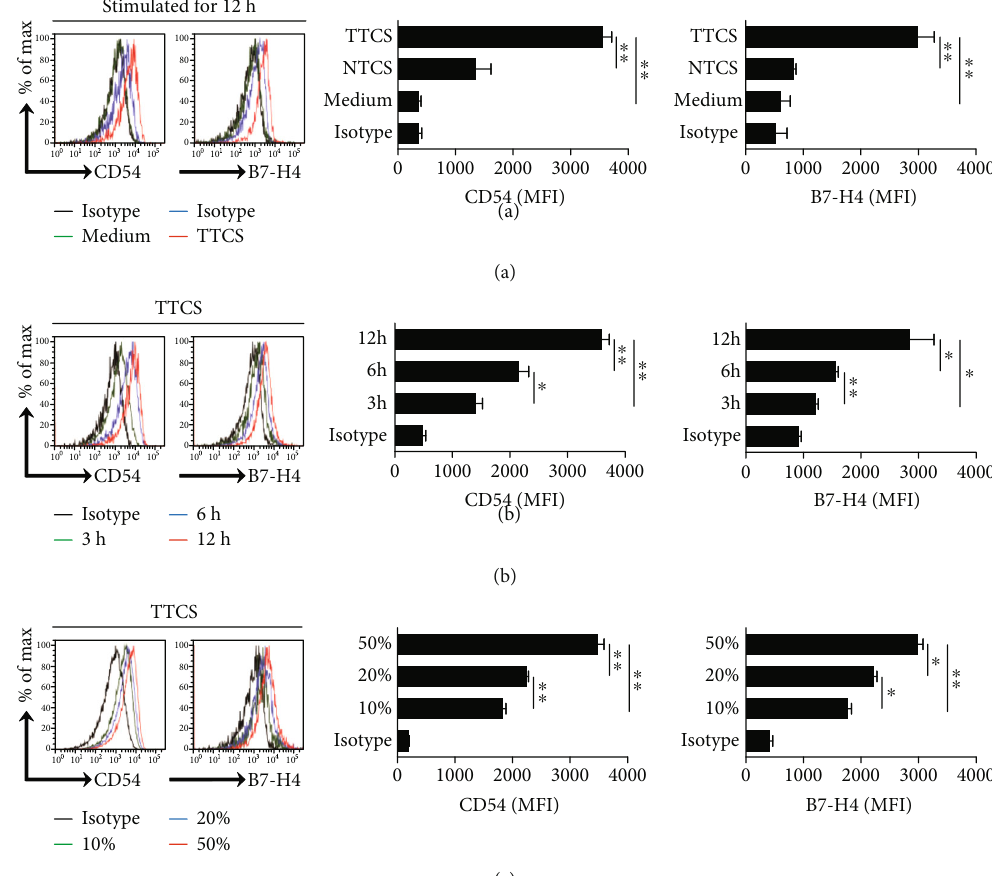
Figure 3: Human GC environments maintain neutrophil-activated and highly B7-H4-expressing phenotype. (a) Expressions of CD54 and B7-H4 on neutrophils exposed to 50% TTCS and 50% NTCS from autologous GC patients, or to medium control for 12 h. Black: isotype control. MFI: mean fl uorescence intensity. (b) Expressions of CD54 and B7-H4 on neutrophils exposed to 50% TTCS from GC patients for 3, 6, or 12 h. Black: isotype control. MFI: mean fl uorescence intensity. (c) Expressions of CD54 and B7-H4 on neutrophils exposed to 10%, 20%, or 50% TTCS from GC patients for 12 h. Black: isotype control. MFI: mean fl uorescence intensity. ∗ P < 0 : 05 and ∗∗ P < 0 : 01 for groups connected by horizontal